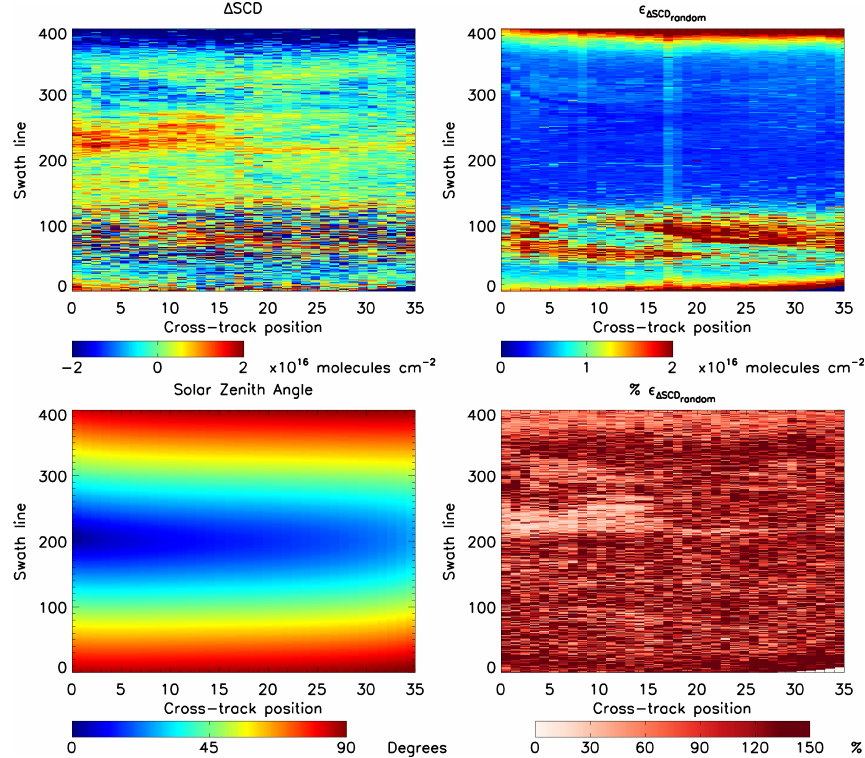
Figure 3. (cid:49) SCD, fitting uncertainty, SZA and relative fitting uncertainty for orbit 3538. The effect of the SAA is clearly visible in the two top panels (swath lines 20 to 120). In the top right panel, which shows the fitting uncertainty, it is possible to appreciate the effect of splitting the central cross-track pixel (Seftor et al.,